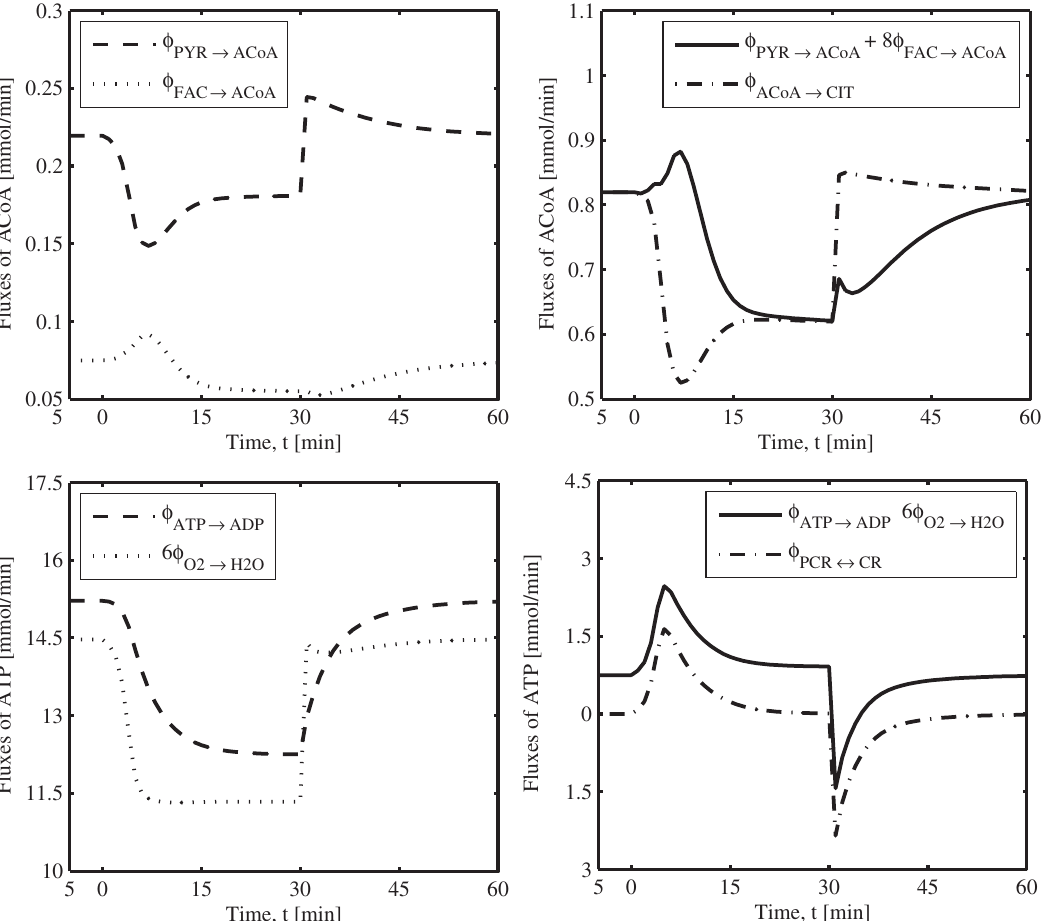
Figure 9. Model-predicted dynamic responses of metabolic reaction fluxes linked to the production and utilization of ACoA (A,B) and ATP (C,D) during the resting, ischemia and recovery periods with a blood flow reduction of about 76%. The responses were computed using the estimated optimal parameter values with the ischemia protocol: if ( t , 0 min | t . 30 min) Q =0.9 L/min, else Q = Q isch =0.216 L/ min. The factors 8 and 6 in plots B and D correspond to the stoichiometries of ACoA and ATP in the production reactions of ACoA and ATP (reactions 18 and 26), respectively.